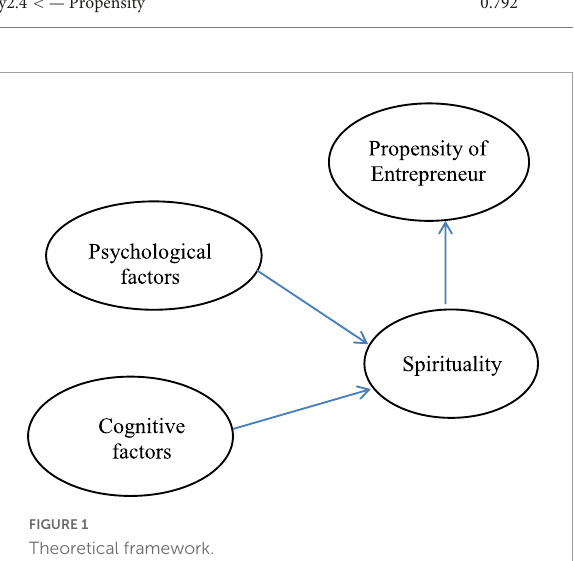
FIGURE1 Theoretical framework.